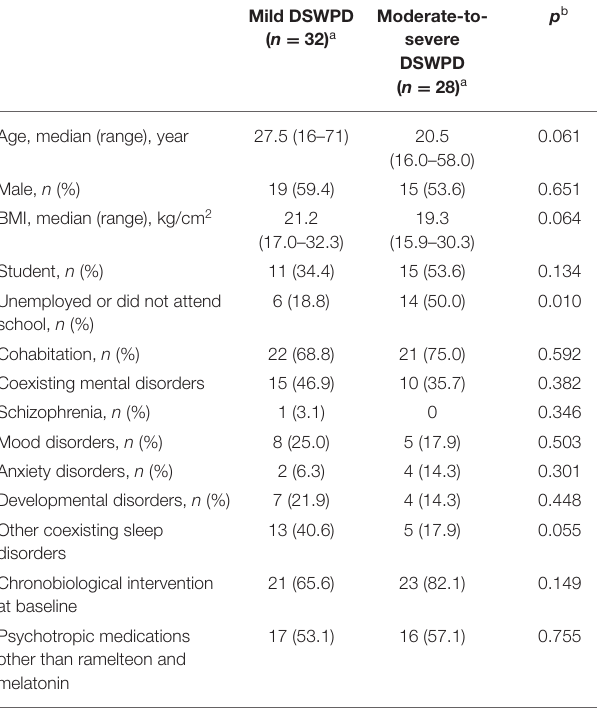
TABLE 1 | Demographic and clinical data of patients with DSWPD ( n = 60). Age, median (range), year